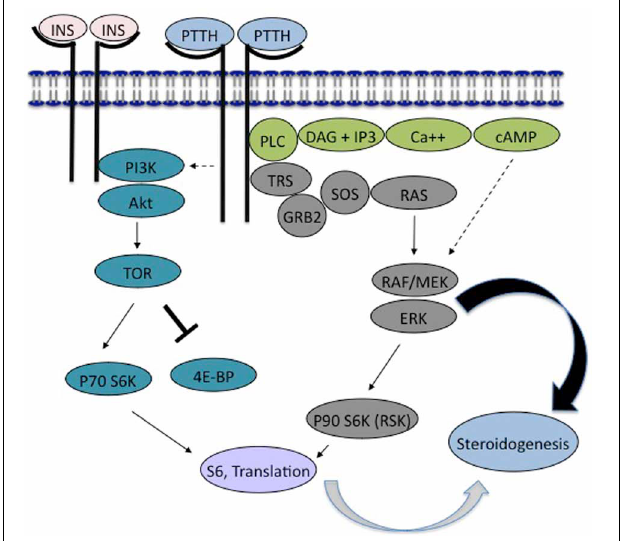
FIGURE 9 | PTTH and insulin signaling pathways in lepidopteran ecdysone secretion. PTTH: In both Bombyx and Manduca , PTTH has been shown to stimulate tyrosine kinase activity. We suggest that this leads to the phosphorylation of a postulated receptor substrate (modeled as Torso Receptor Substrate, TRS), capable of interacting with PLC (phospholipase C). PTTH is known to increase intracellular calcium, activate calcium-sensitive adenylyl cyclase (not shown), and to elevate cyclic AMP. TRS is postulated to recruit the adapter protein GRB2 and SOS, enhancing the activity of RAS and RAF, leading to known activation of MEK, ERK, and RSK. Cyclic AMP is also suggested to act via an effect on the MAPkinase pathway (dotted line). Insulin/Bombyxin: In both Bombyx and Manduca, insulin or bombyxin activate PI3K and Akt, which is presumed to increase the activity of TOR (target of rapamycin) through proteins not shown. TOR enhances translation by suppressing the translation inhibitor 4E-binding protein (4EBP), and activating p70 S6 kinase, which targets ribosomal protein S6. The primary difference seen between the prothoracic glands of Manduca and Bombyx is the ability of both insulin and PTTH to activate the insulin signaling pathway in Bombyx (PI3K, Akt, TOR, 4EBP) and by this pathway to stimulate ecdysone secretion (Gray curved arrow). By contrast, in Manduca, although PTTH stimulates the phosphorylation of 4EBP suggesting activation of PI3K (dotted line), the insulin signaling pathway is neither sufficient, nor required, for ecdysone synthesis. Instead, secretion is mediated by PTTH-stimulated activation of MAPkinases (Black curved